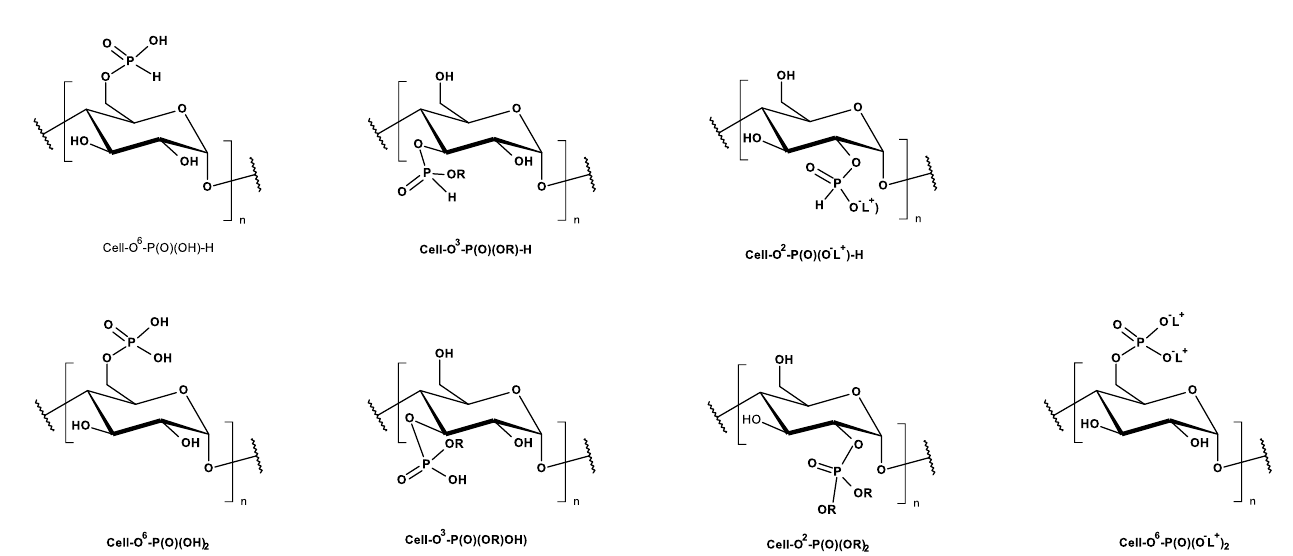
Figure 1. Major types of cellulose phosphates (III/V), derived from cellulose and phosphoric (III/V) acids (R = alkyl, aryl; L + = cations). Position of phosphorylated HO group of cellulose is described using i-index at oxygen atom: as Cell- O i -phosphate group at i-atom of carbon ring (I = 2, 3, 6) and in the case of 6-phosphate Cell-O 6 -.